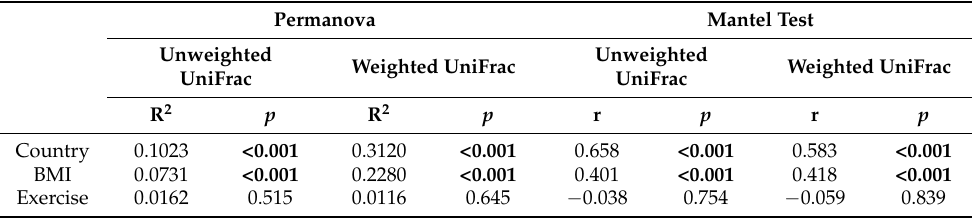
Table 1. PERMONOVA and Mantel test determining the influencing factors of gut microbial communities.